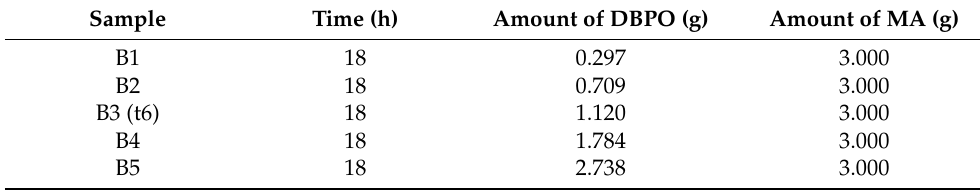
Table 3. Experimental design for the factor of the addition amount of